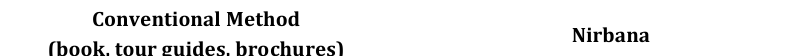
Table 1 Comparison between Nirbana and Conventional Methods Conventional